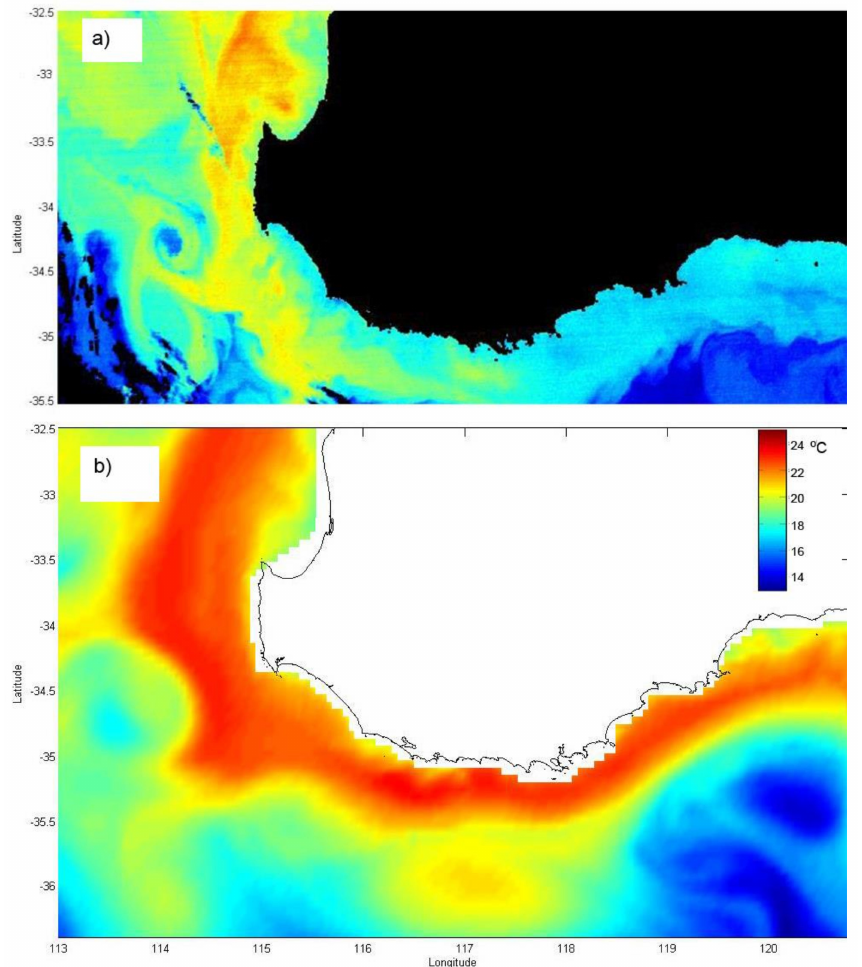
Figure 2. ( a ) National Oceanic and Atmospheric Administration (NOAA) satellite image of south-west Australia on 9 April 2006. The warm water (shown in red / orange) represents the Leeuwin current. ( b ) A model output of the surface temperature representing circulation in the autumn and showing an eddy o ff shoot